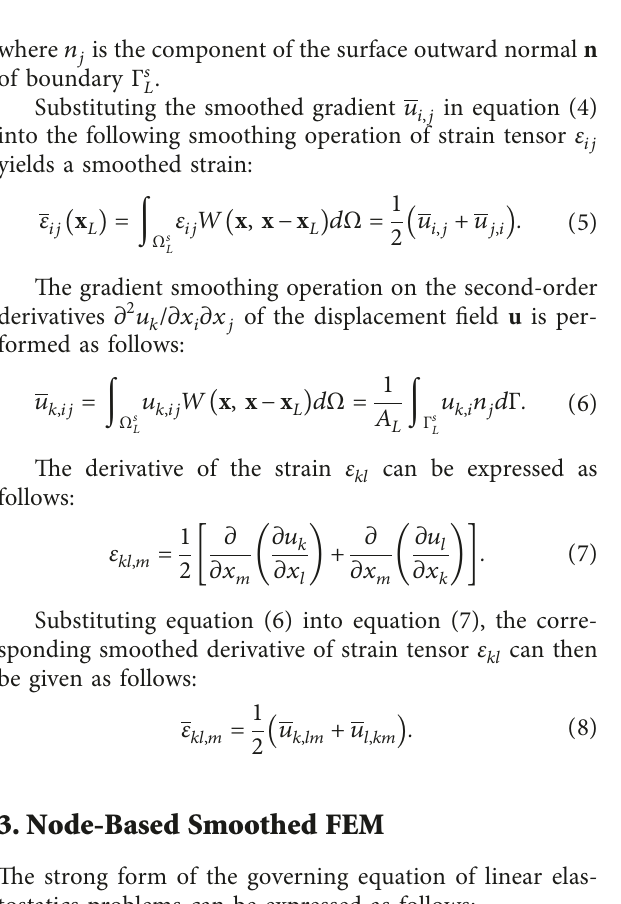
Figure 1: Triangular elements and smoothing cells associated with